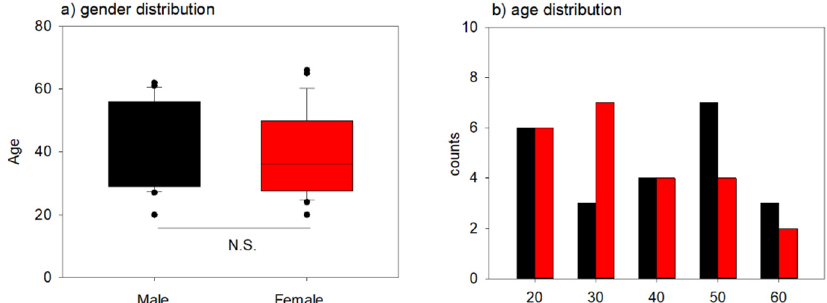
Figure 1. Age distribution in male and female groups. ( a ) Age distribution of male and female groups ( n = 23 for each). ( b ) Age-dependent histograms of donor counts of both gender groups; “20” on the X-axis represents ages between “20–29”. Similarly, the other labels represent the corresponding age groups. The black and red columns represent male and female groups, respectively. The block dots represent outliers.